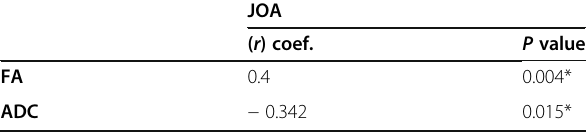
Table 2 Correlation between DTI parameters and JOA scores